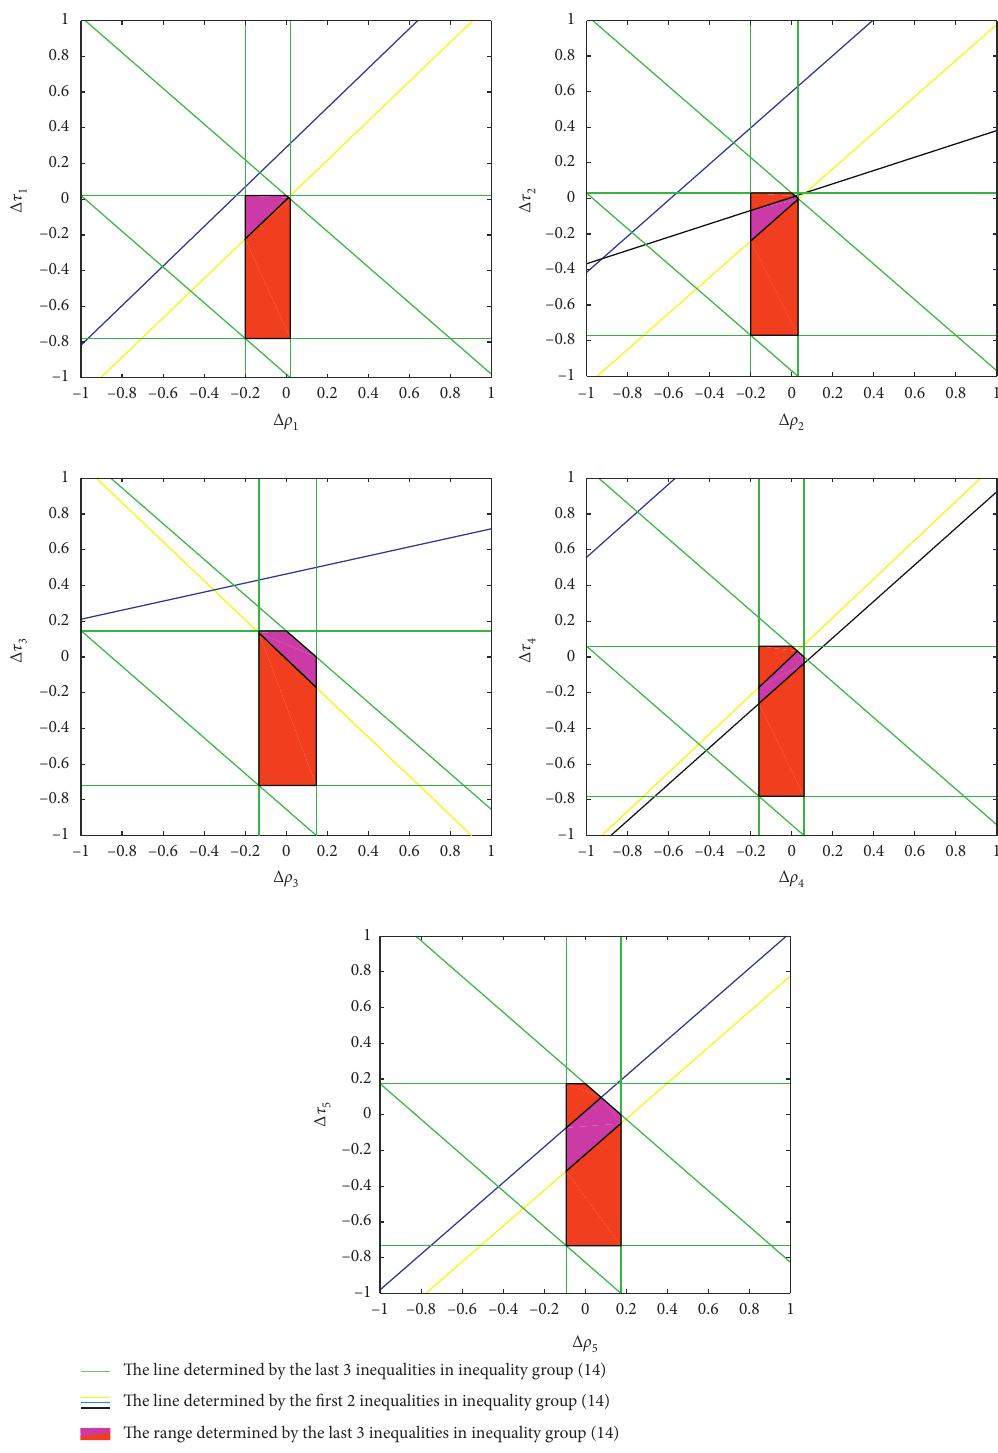
Figure 6: The range of index weight